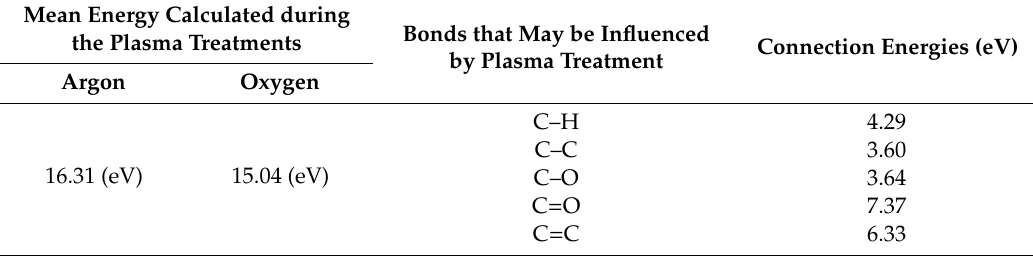
Table 2. Calculated plasma energy and energy of chemical bonds.